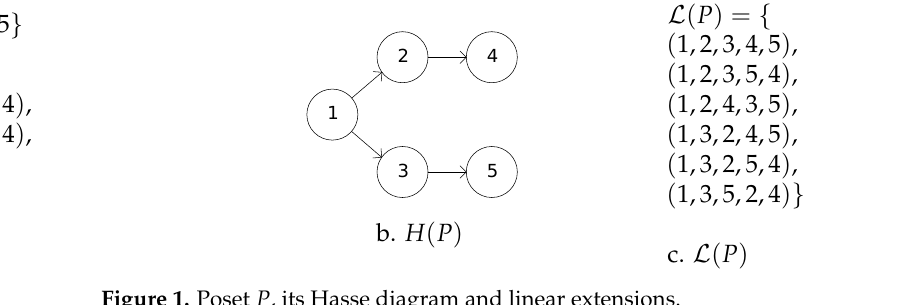
Figure 1. Poset P , its Hasse diagram and linear